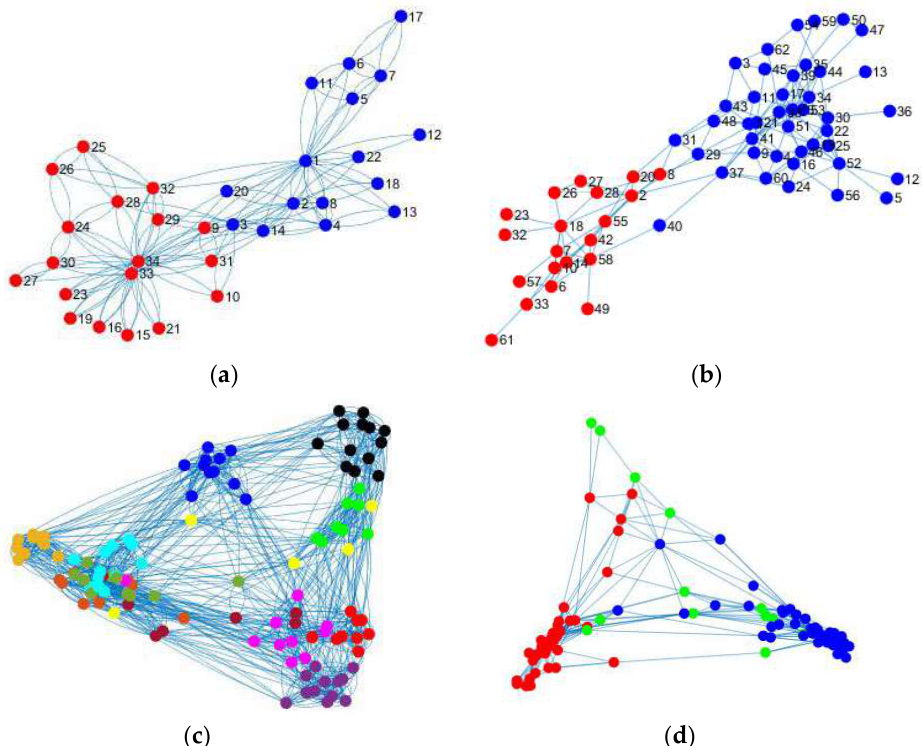
Figure 9. The community structure of datasets network: ( a ) the Zachary’s karate club network; ( b ) the Bottlenose dolphins network; ( c ) the American college football network; ( d ) the Political books network.